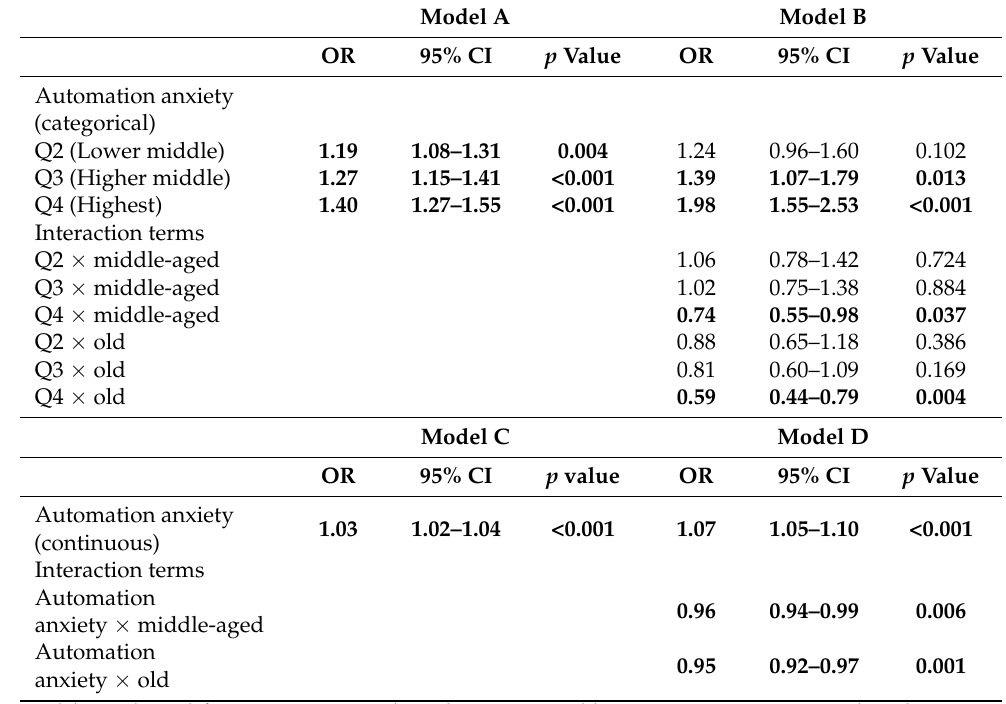
Table 3. Association of automation anxiety and insomnia by logistic regression models. Bold indicates statistically significant values. [OR: odds ratio; CI: confidence interval]. Model A Model B OR 95% CI p Value OR 95% CI p